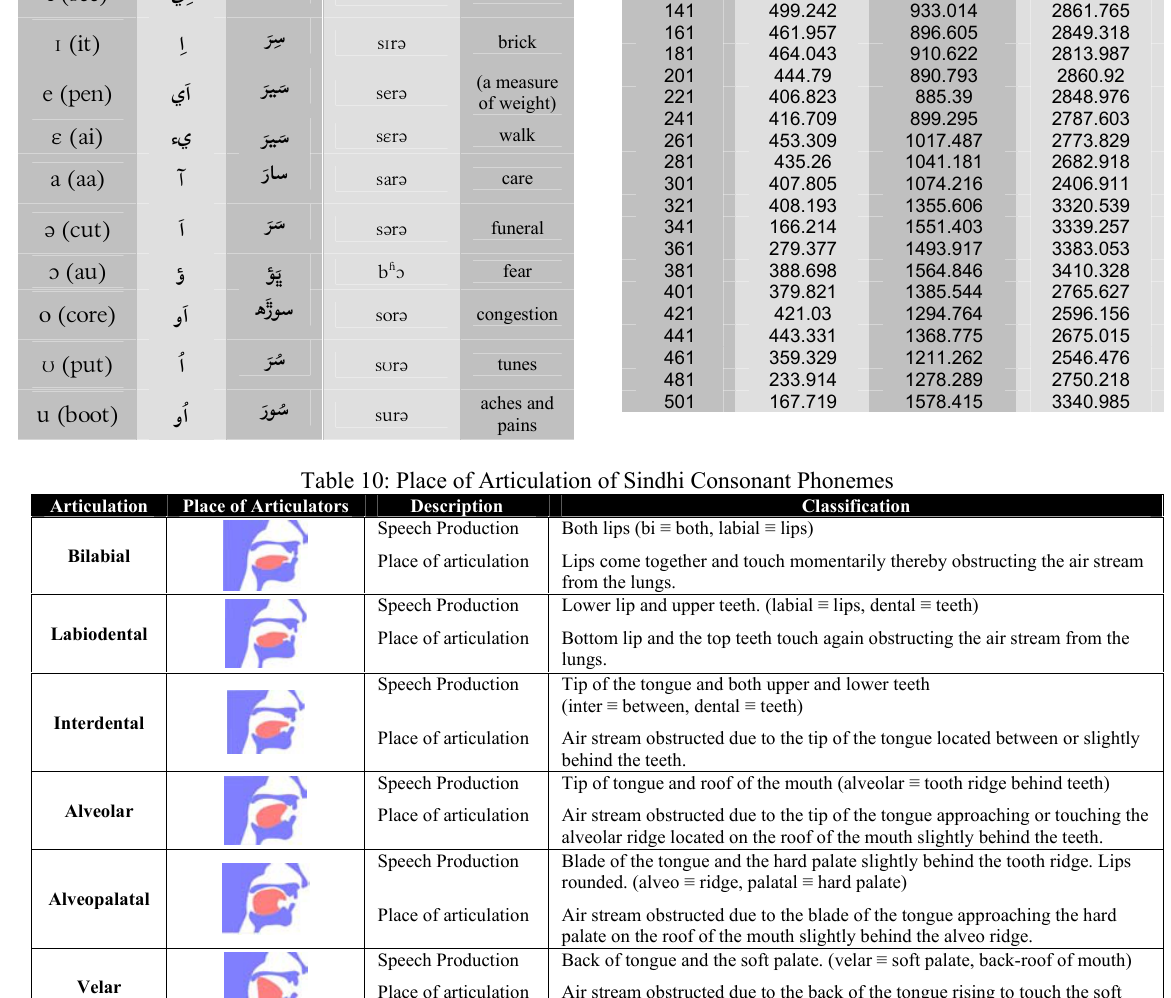
English Meaning